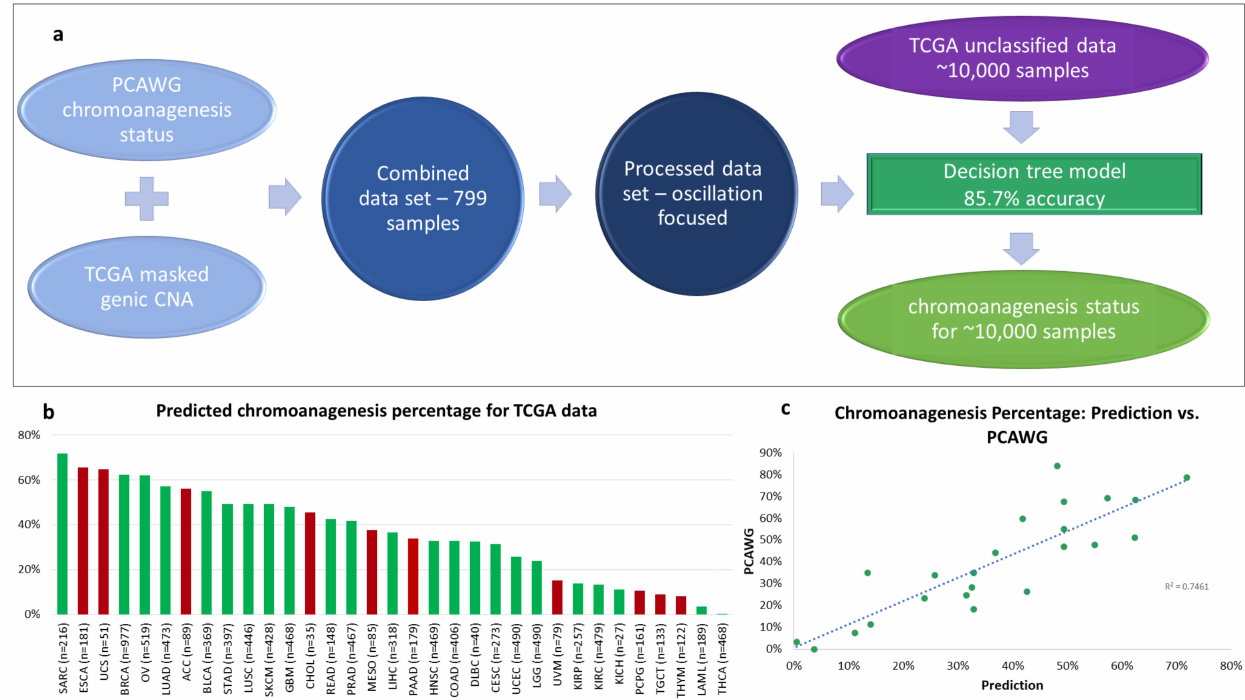
Figure 4. Chromoanagenesis prediction. PCAWG and TCGA data were integrated and processed to train a machine learning (ML) model ( a ) The selected model has an accuracy rate of 85.7%. It was applied to predict chromoanagenesis status for the remaining 9929 TCGA individuals. ( b ) Predicted chromoanagenesis rate for all 33 cancer types in TCGA. Bars of the histogram representing chromoanagenesis percentage estimates for cancer types not included in the training set are colored red. ( c ) Correlation between predicted chromoanagenesis rate and the PCAWG reported chromoanagenesis rate for shared cancer